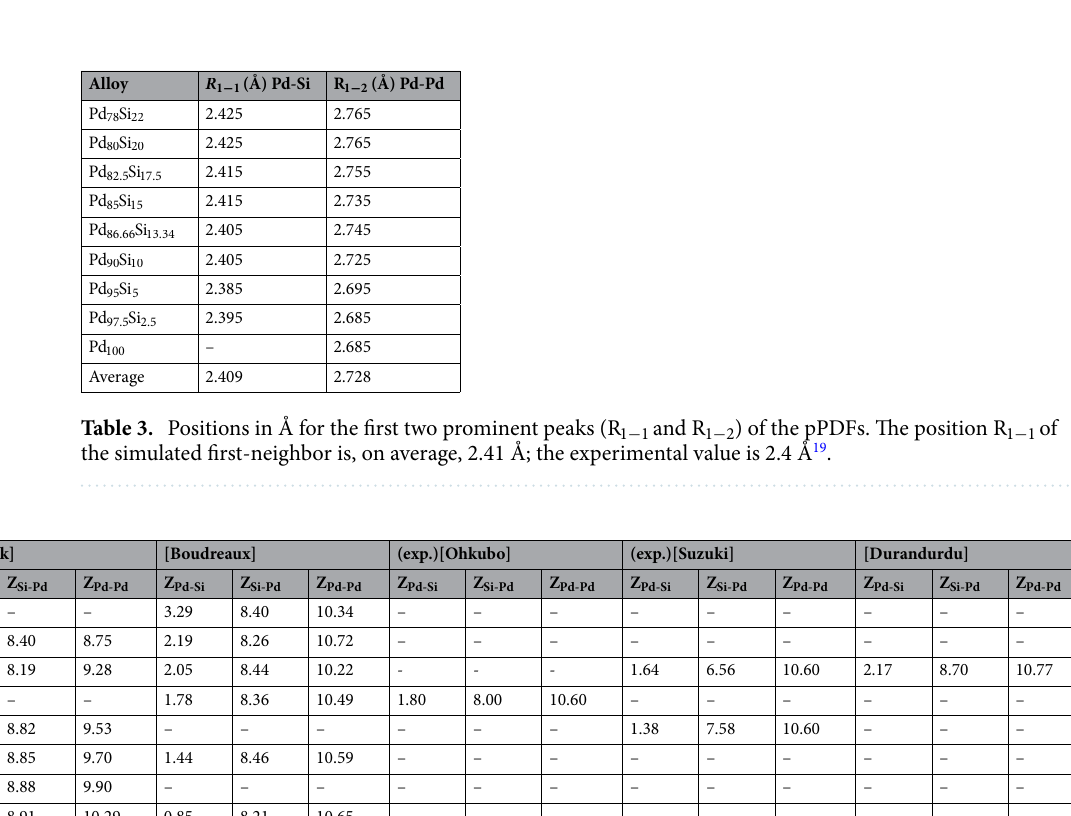
Table 2. AMM per atom for the pure bulk, amorphous, sample of palladium and the eight alloys studied in this work. Two curve fittings are shown in Fig. 6.